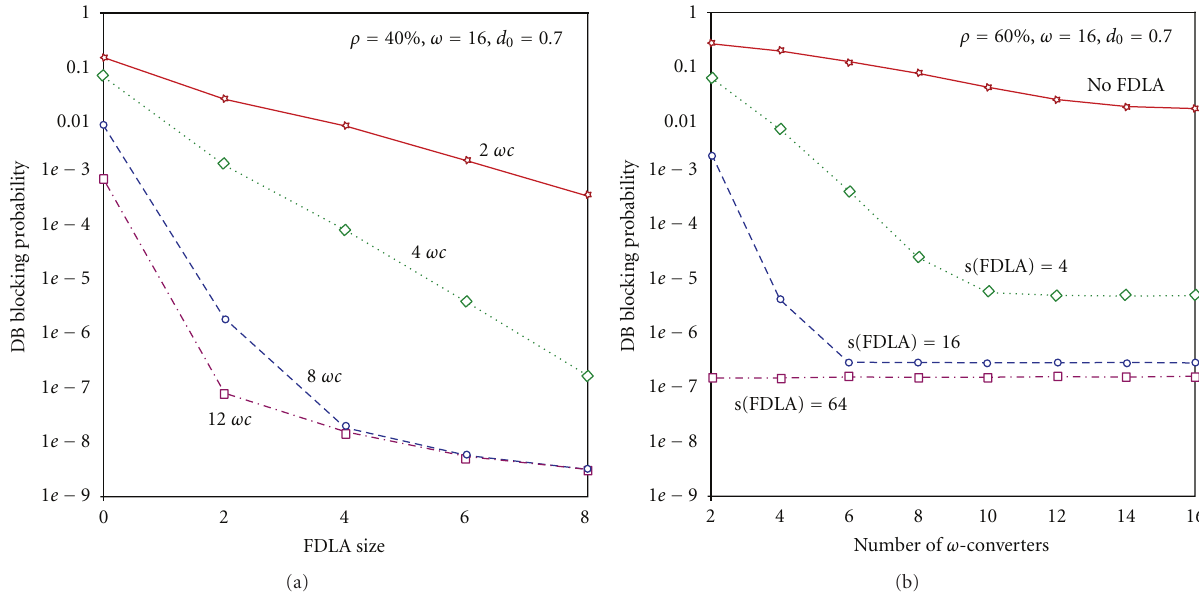
Figure 5: Burst contention reduction achievable with FDLAs and ω -conversion per output fibre for an array granularity d 0 = 0 . 7 average burst length at (a) 40% load and (b) 60%